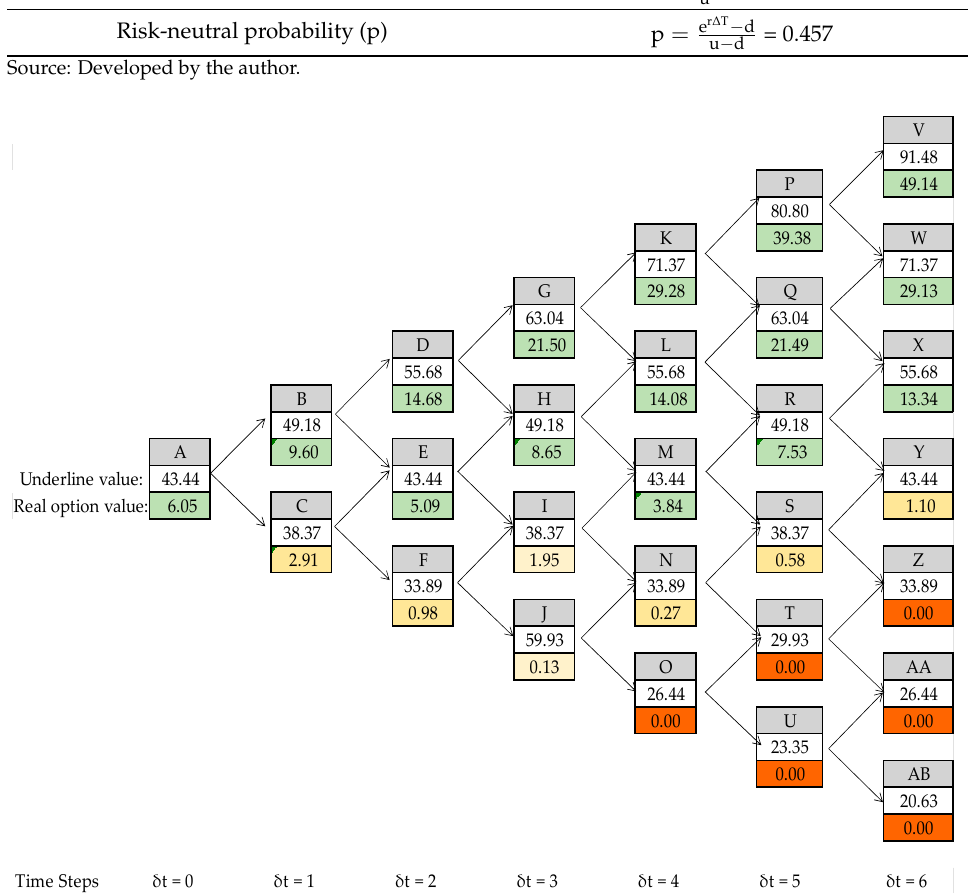
Figure 2. The underlying values lattice ( upper ) and the real options valuation lattice ( down ) in USD bn. Source: Developed by the author.